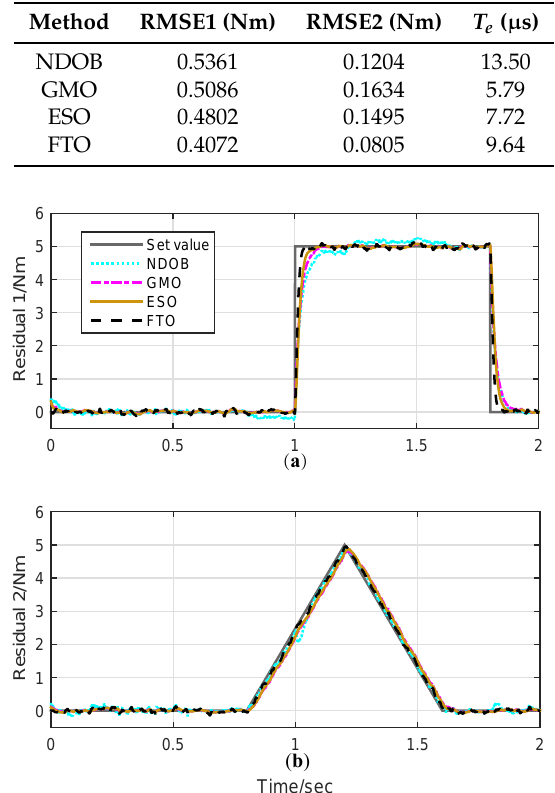
Table 1. A comparison of nonlinear disturbance observer (NDOB), generalized momentum observer (GMO), external state observer (ESO), and FTO methods.